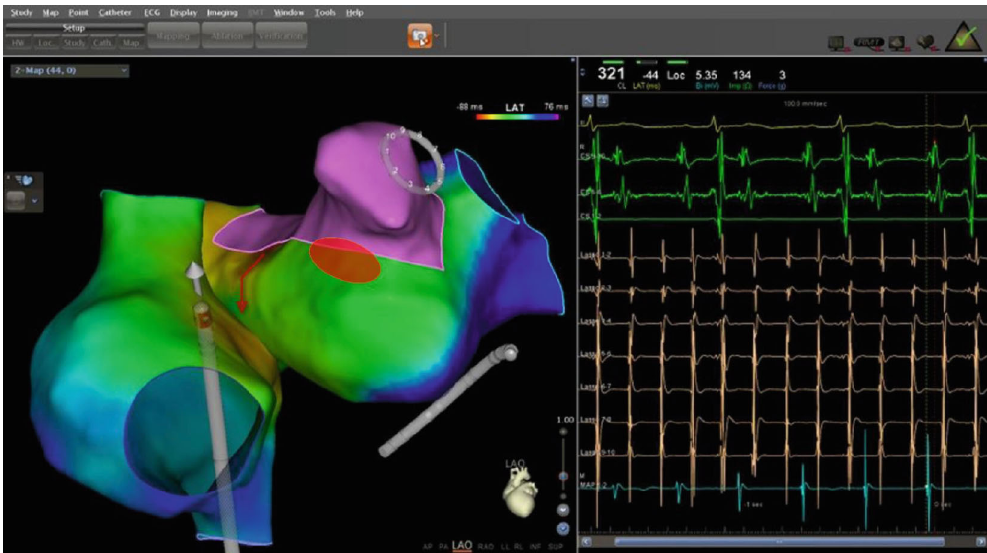
Figure 1: Activation mapping of the LA and RA. The LAA and surrounding area is in AF (pink, average cycle length 150 ms); the rest of the atria including the anterior and lateral walls of the LA, the interatrial septum, and the RA are in atrial fl utter (cycle length 330ms, earliest in CS 9, 10). Red circle marked the area ablated during CFAE ablation.